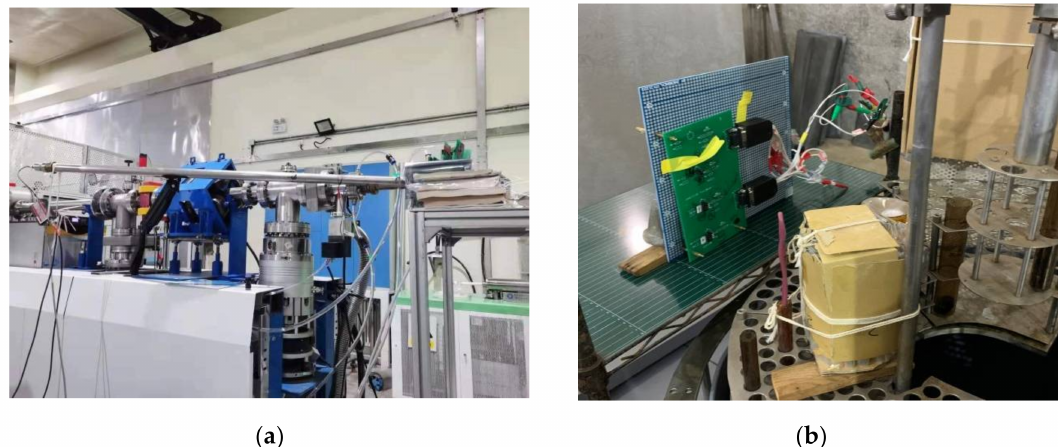
Figure 1. The experimental setup of ( a ) DDD and ( b ) TID